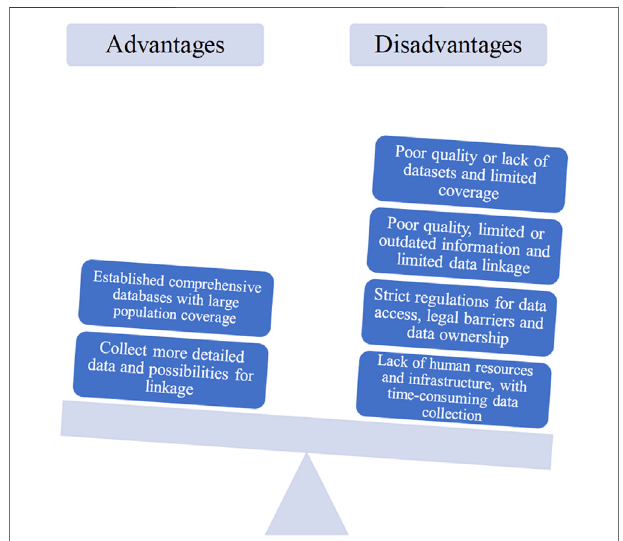
FIGURE 5 | Main advantages and disadvantages of data collection systems for oncology identi fi ed by the participants.